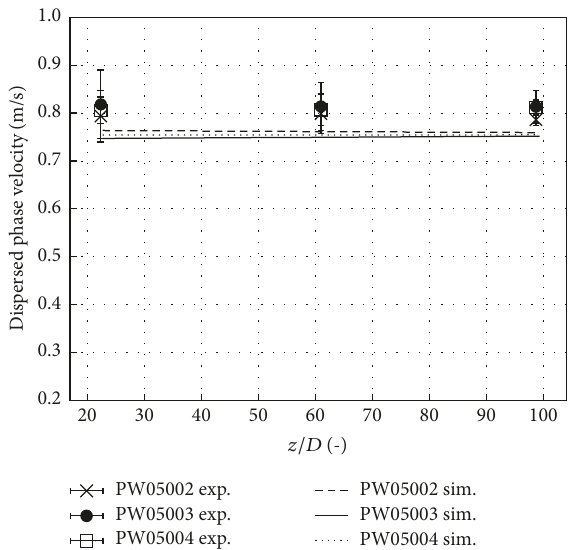
Figure 13: Comparison between computational results and experi- ments of the dispersed phase velocity axial